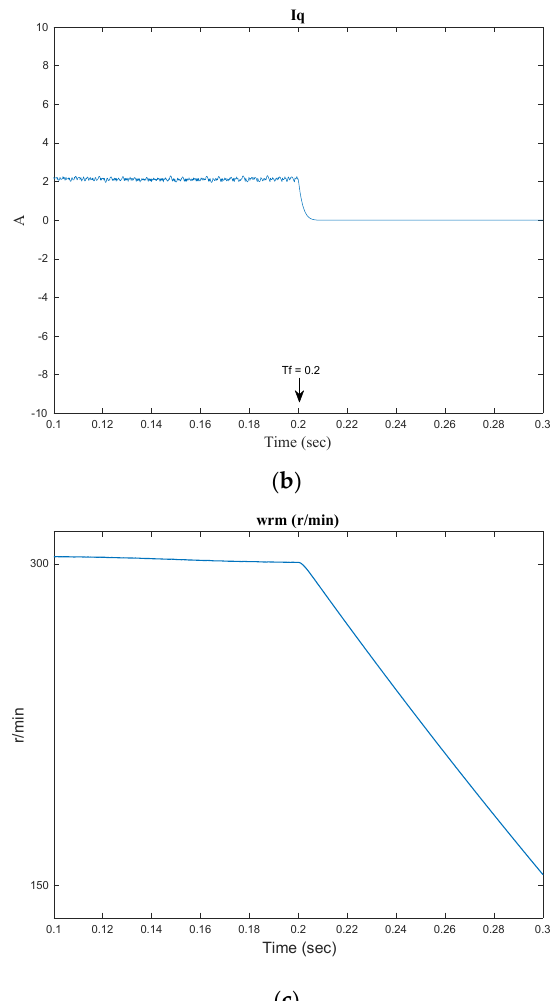
Figure 17. Simulated results when the a -phase was short-circuited without using the fault-tolerant method: ( a ) three-phase currents; ( b ) q -axis current; ( c ) speed response.